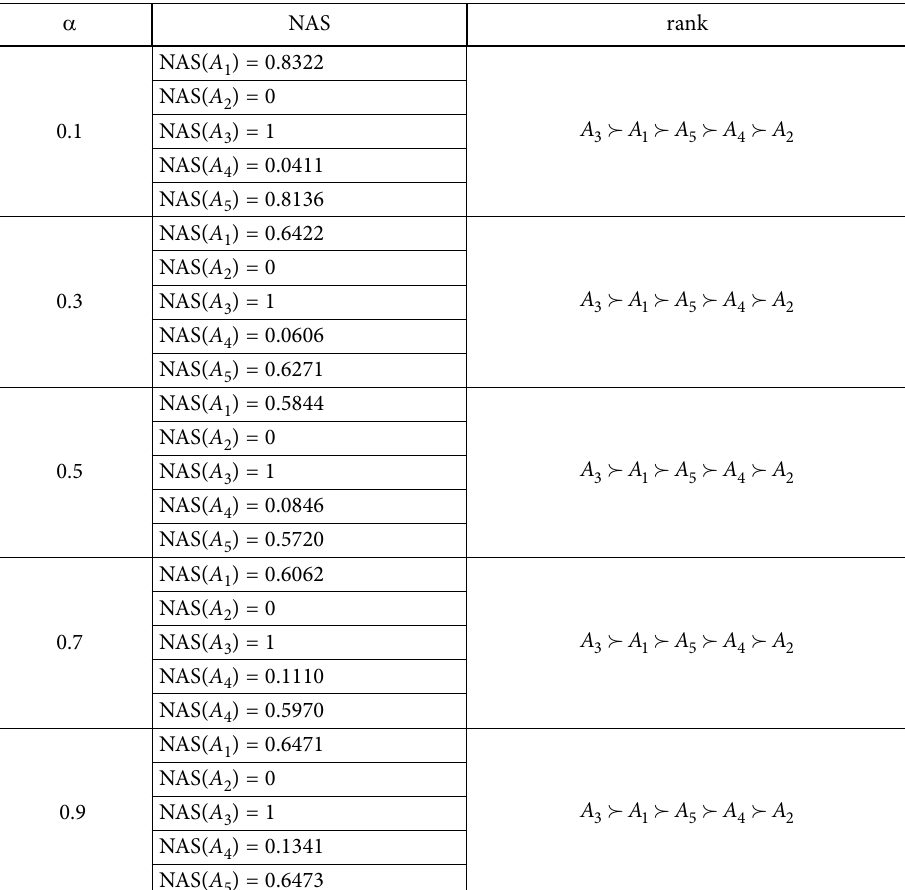
Table 20. the rank results of different values of